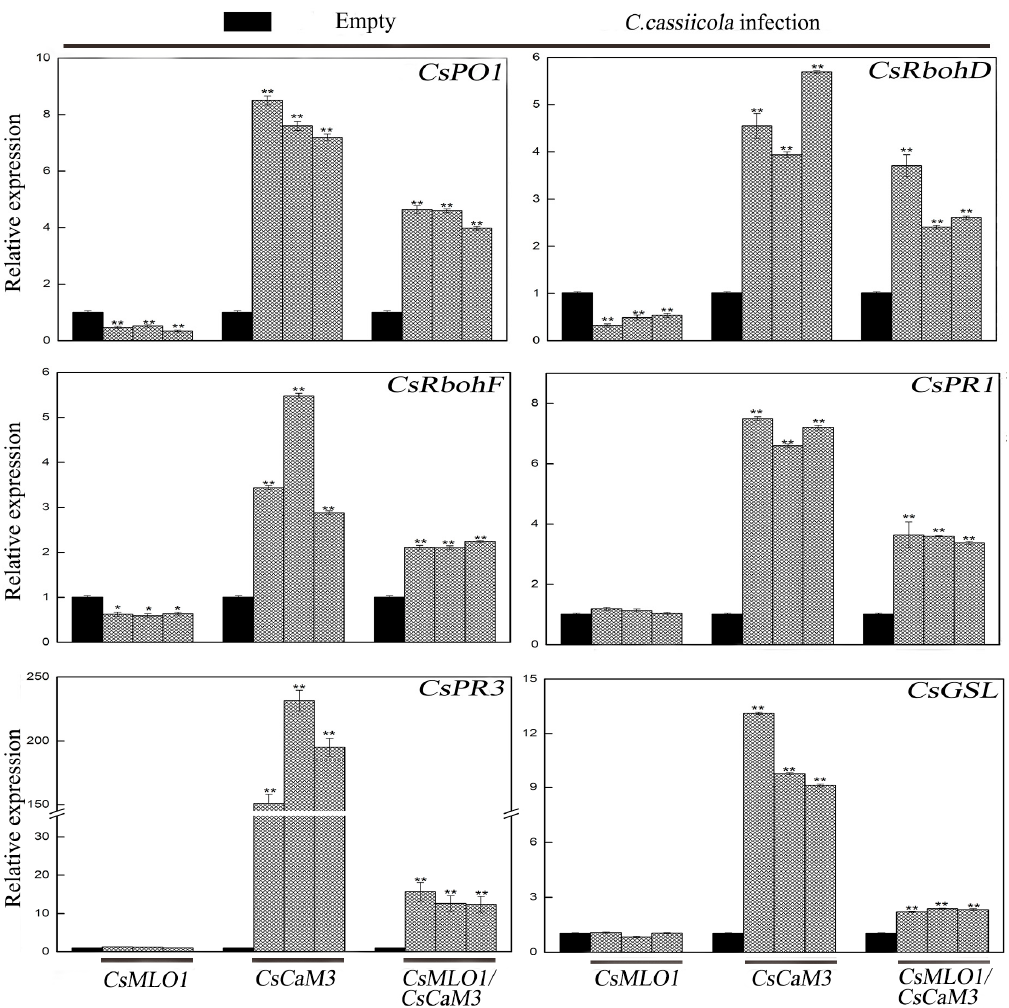
Figure 10. Expression analysis of the CsRbohD , CsRbohF , CsPO1 , CsPR1 , CsPR3 and CsGSL genes were determined by RT-qPCR in cucumber cotyledons 5 d after C. cassiicola inoculation. Data are the means ± standard deviations from three biological experiments, and each column represents a sample containing three of cucumber cotyledons from different plants. Expression analysis of candidate genes using the 2 −ΔΔ Ct method. The asterisks indicate a significant difference (Student’s t test, *P < 0.05 or ** P < 0.01).